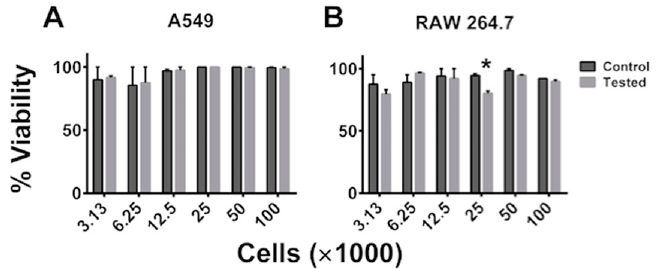
Figure 3. Cell viability following SAW measurement. Immediately following SAW measurement the viability of ( A ) A549 and ( B ) RAW 264.7 cells was determined by trypan blue exclusion. Data is plotted as mean ± standard error of the mean. The data is a representative of a study that was performed in triplicates and performed at least two independent times. A student’s t -test was used to evaluate significance (* p ≤ 0.05, when compared to control).